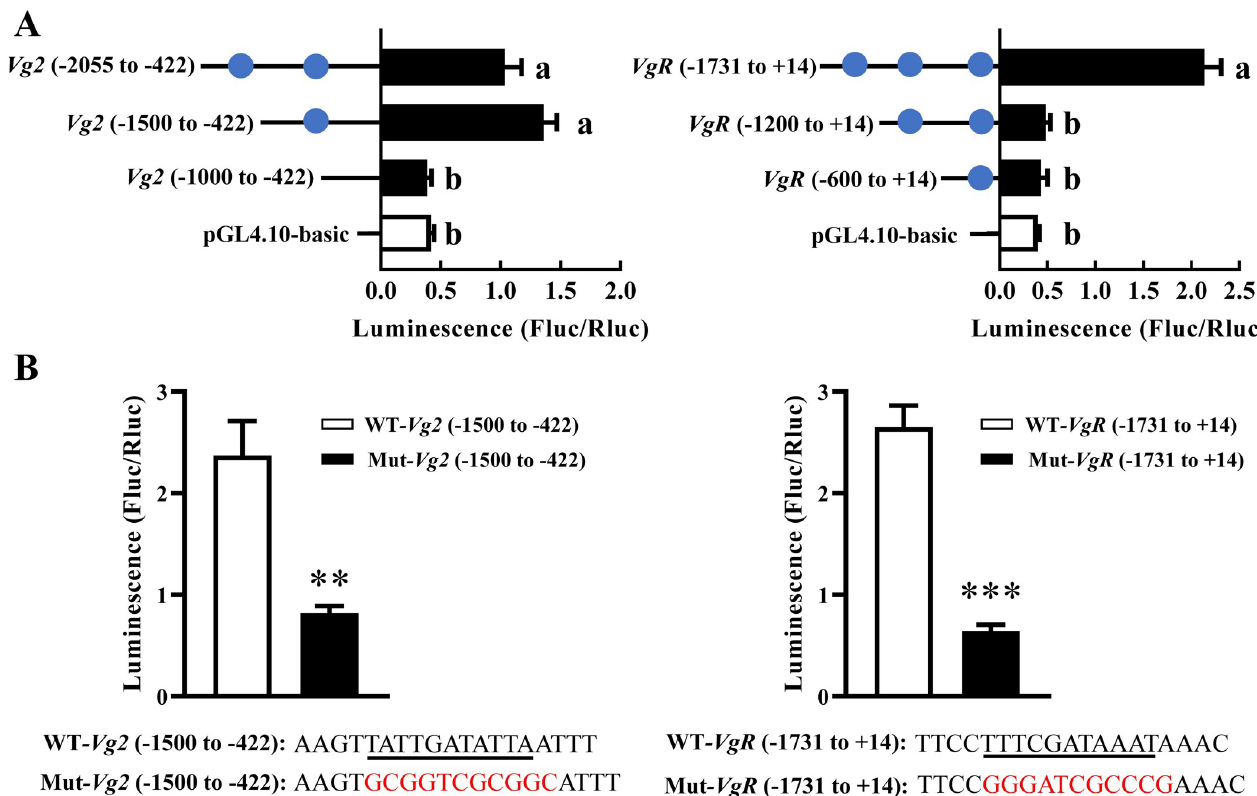
Fig 6. The luciferase activities in cells transfected with Vg2 / VgR promoters and pnr expression construct. (A) pGL4.10- Vg2 or pGL4.10- VgR promoter fragments and pGL4.74 were co-transfected into HEK293T cells with the transcription factors pnr in pcDNA3.1-EGFP. pGL4.10-basic vector was used as a control. A blue circle indicates a predicted binding site responding to pnr . (B) The luciferase activities of pGL4.10- Vg2 − 1500 to –422 or pGL4.10- VgR –1731 to +14 promoter with the mutant binding sites. Underlined sequence means the putative binding sites, and the sequence in read represents the mutant binding sites. Data are means ± SE (error bars) of four biological replications. The differences between means were analyzed by Student’s t test. For the significance test: �� P < 0.01; ��� P < 0.001. Different letters above the bars indicate significant differences among pGL4.10- Vg2 or pGL4.10- VgR promoter fragments (Tukey HSD, ANOVA, P < 0.05).